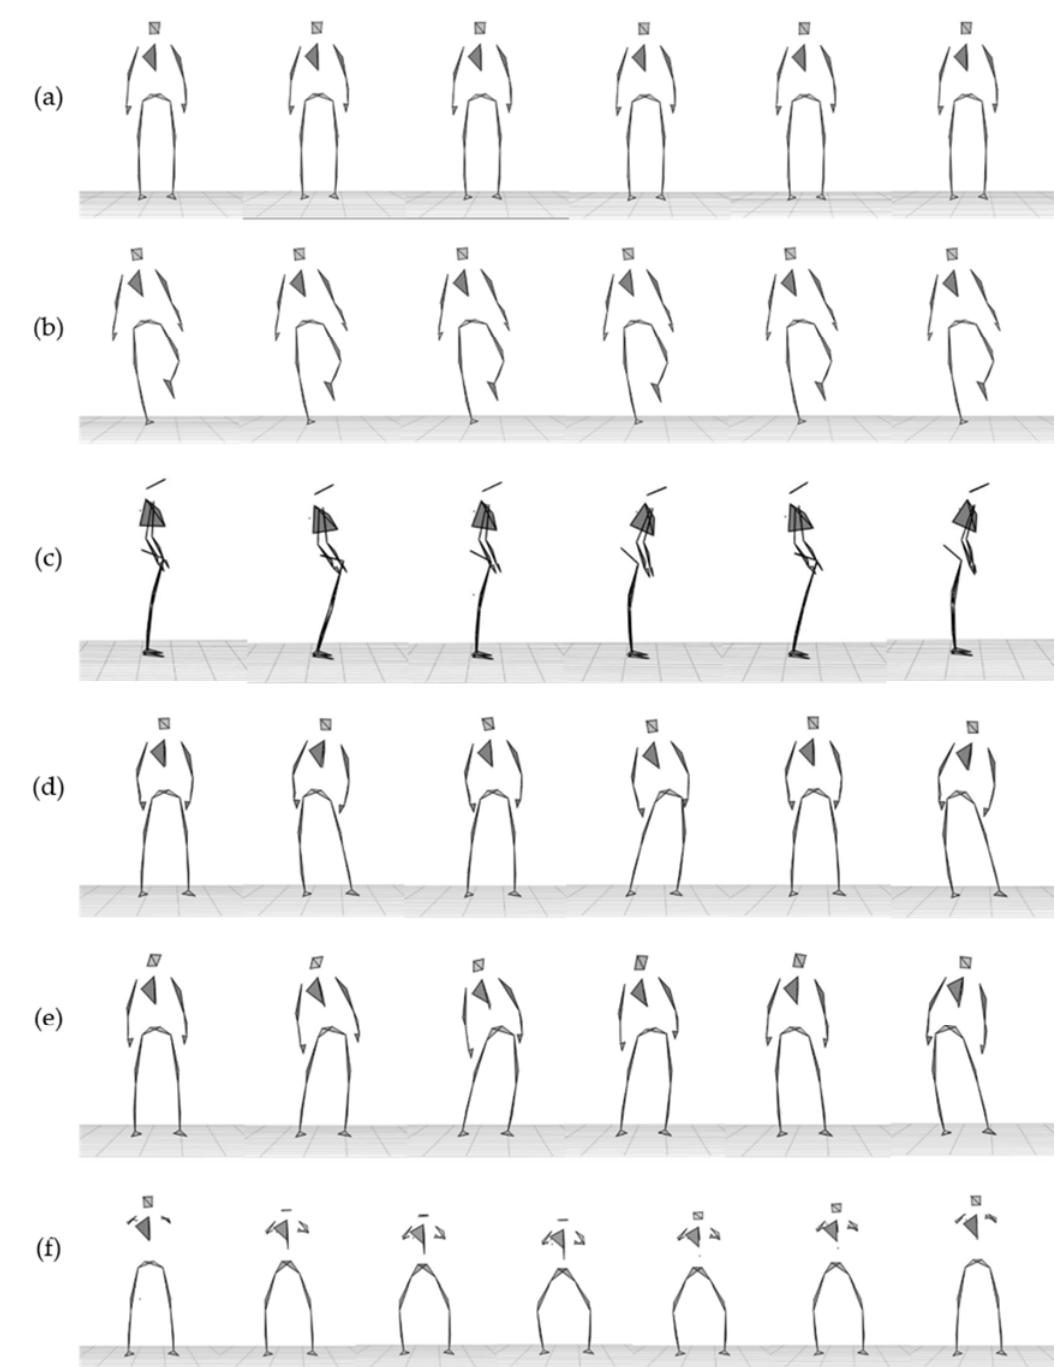
Figure 2. The overall marker-set tracked by the OS of a healthy subject performing the experimental protocol. (a) Double Leg Stance task, (b) Single Leg Stance task, (c) Anterior–Posterior (AP) sway task, (d) Mediolateral (ML) sway task, (e) Free sway task, and (f ) Squat task.